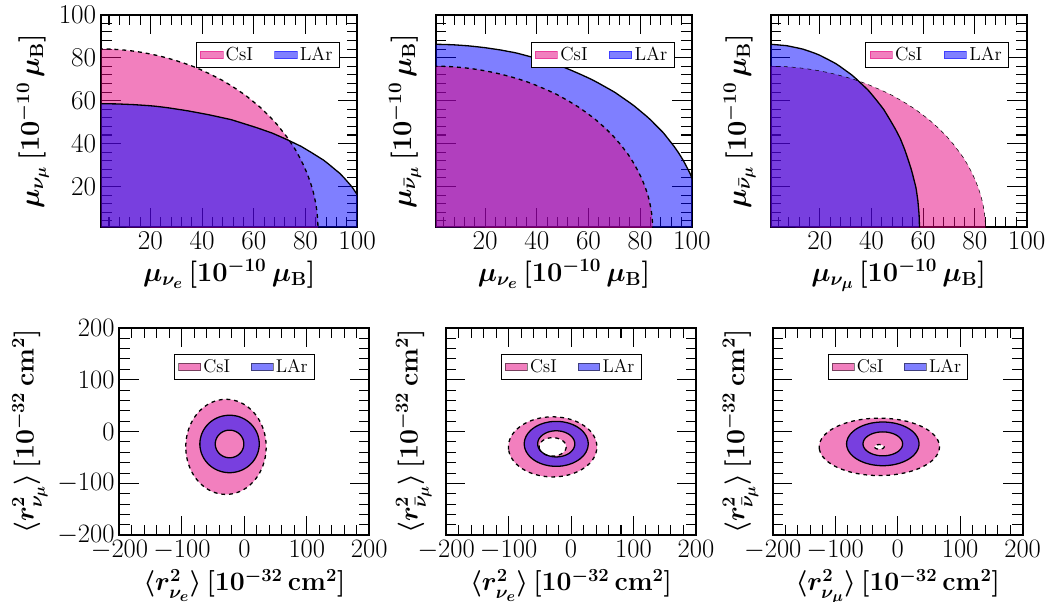
Figure 6 . Upper panel: 90% C.L. allowed region in the parameter space of the neutrino magnetic moments ( (cid:22) (cid:23) ; (cid:22) (cid:23) ). Lower panel: 90% C.L. allowed region in the parameter space of neutrino (cid:11) (cid:12) charge radii ( r 2 ; r 2 ). The results are shown for di(cid:11)erent choices of neutrino (cid:13)avours, with the (cid:23) (cid:11) i (cid:23) (cid:12) i h h undisplayed parameters in each case assumed to be vanishing. For comparison, we show the results from the analysis of CsI and LAr